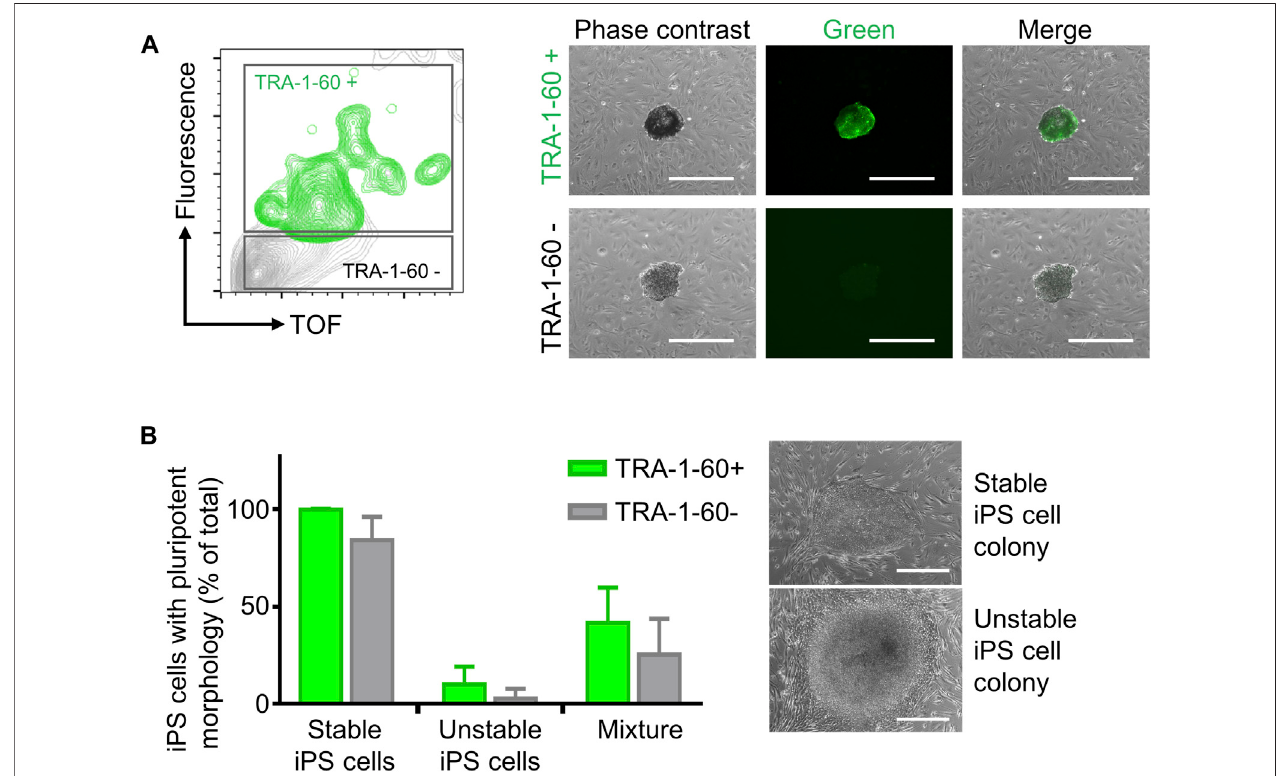
FIGURE3| EnrichmentofTRA-1-60positiveiPScellclusters. (A) RepresentativegatingstrategyforsortingiPScellclustersstainedwithTRA-1-60(left).TRA-1-60 positive sorted iPS cell clusters showed homogeneous TRA-1-60 staining by fl uorescence microscopy (right). Scale bar: 500 µm. (B) Quality assessment of TRA-1-60 positiveandnegativeiPScellclustersderivedfromstableandunstableiPScelllinesaftercellclustersorting.Mixture:StableandunstableiPScellclusterweremixedin1: 1 ratio, stained with TRA-1-60 and subjected to cell cluster sorting based on TRA-1-60 expression. Higher numbers of iPS cell colonies with iPS/ES cell morphology are observed in TRA-1-60 positive vs. TRA-1-60 negative populations, although not statistically signi fi cant (stable, n = 3, p = 0.0874, unstable, n = 3, p = 0.3017, mixture, n = 3, p = 0.3360). Stable and unstable cell lines were de fi ned by their morphology and level of spontaneous differentiation in culture. Representative images of iPS cell colonies with pluripotent and unstable/differentiated morphology are shown (top and bottom images respectively, scale bar: 500